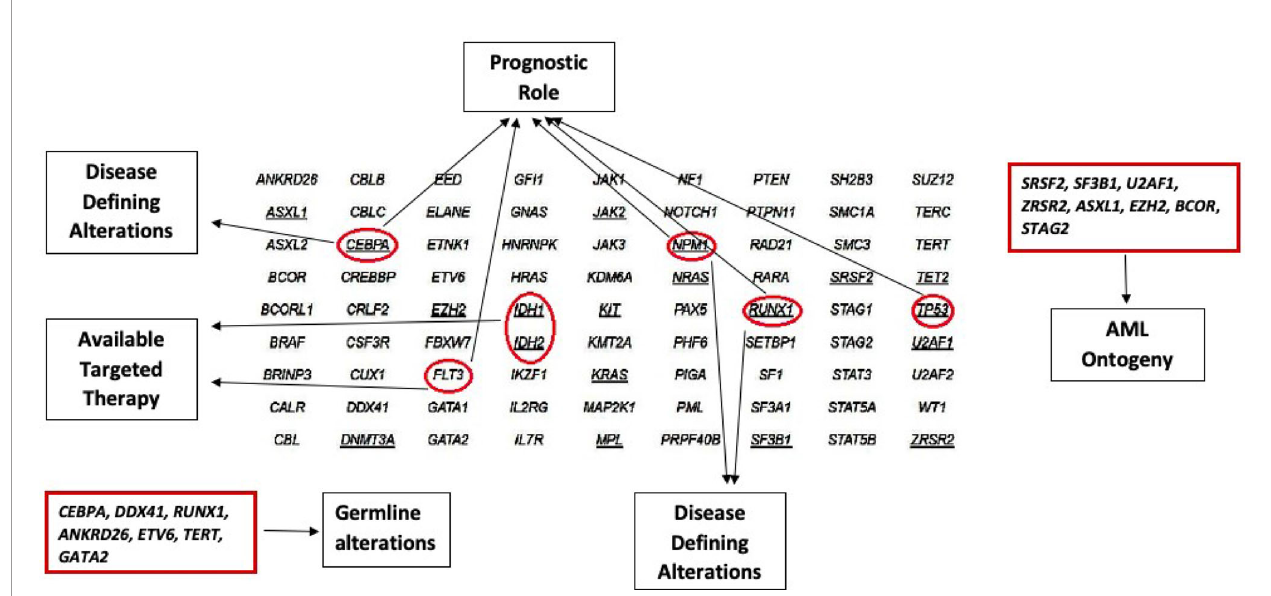
FIGURE 2 | Role of different Genetic Alterations as Diagnostic, and Prognostic markers, as well as the Availability of Targeted